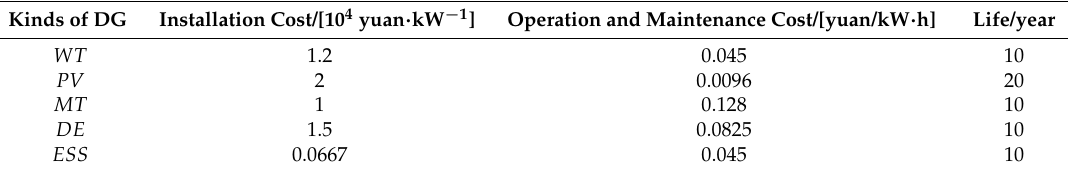
Table 2. Parameter of various distributed generation.